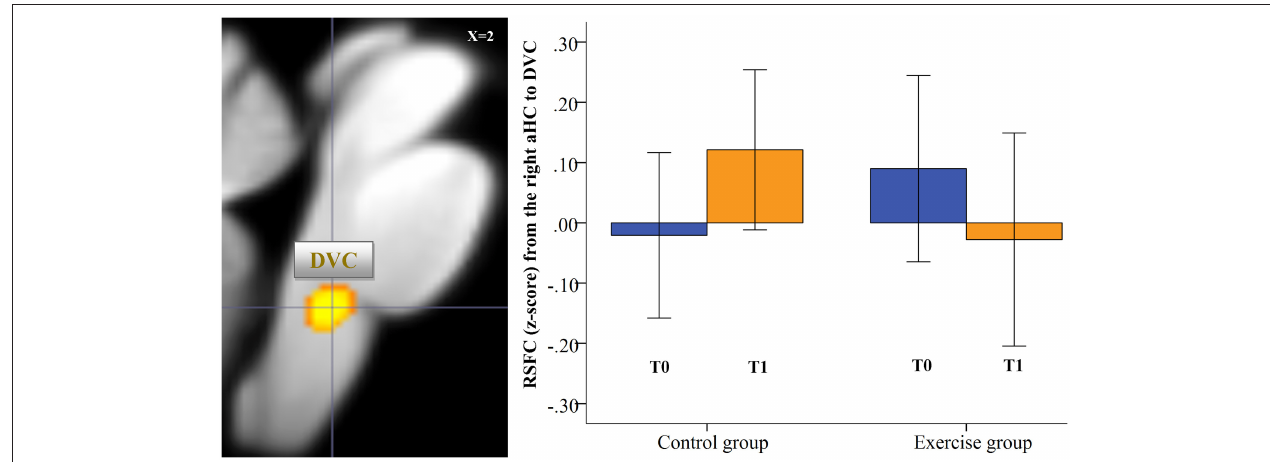
FIGURE 5 | Significant exercise-induced changes of the functional connectivity of the right aHC at the brainstem/cerebellum level. Significant Group (exercise vs. control group) × Time (before vs. after intervention) interaction ( post-hoc t-test ) for the functional connectivity of the right anterior hippocampus ( p < 0.001 uncorr, p < 0.05 cluster-level FWE corr.) at the brainstem/cerebellum level as preprocessed with the SUIT toolbox. The box chart depicts significant changes in the FC between the right aHC and a significant cluster located in the dorsomedial medulla, where a number of autonomic centers are located and which is in the vicinity of the previously described dorsal vagal complex (DVC, Blessing,